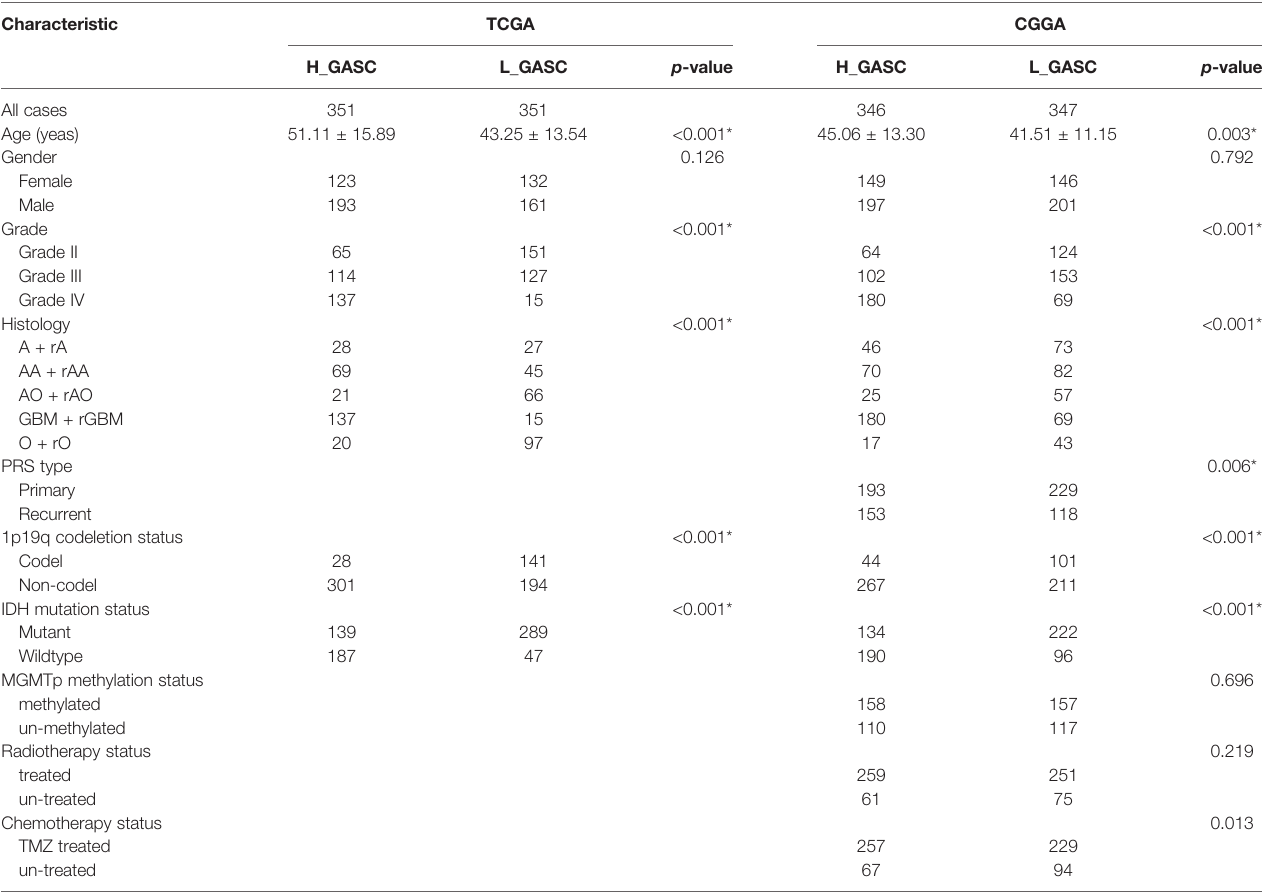
TABLE 1 | Correlations between GASC groups and clinical characteristics in glioma